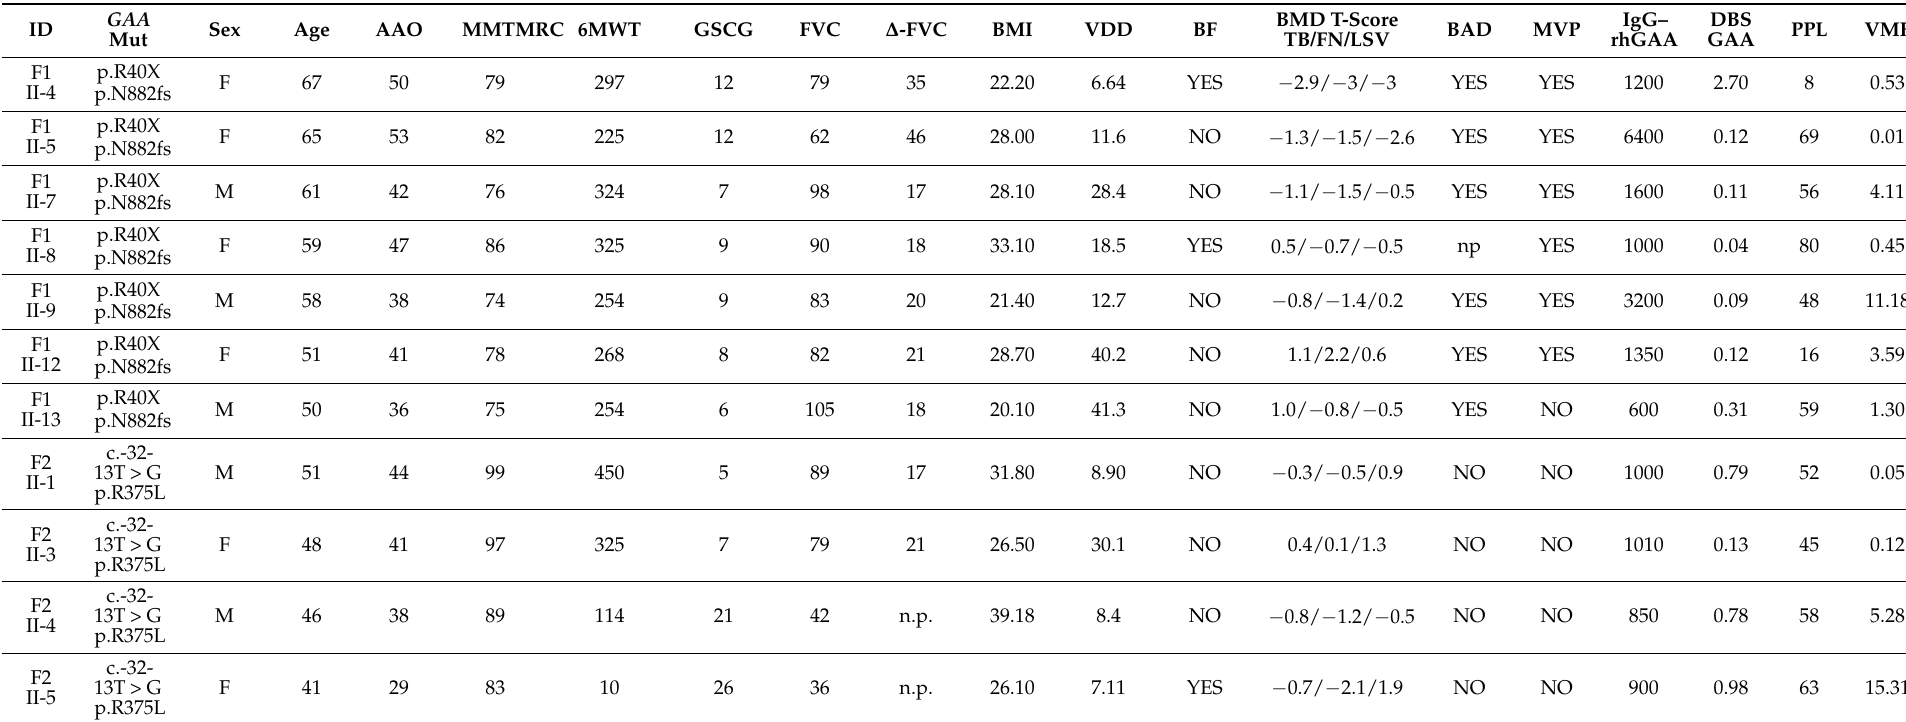
Table 1. Clinical data of the two LOPD Italian